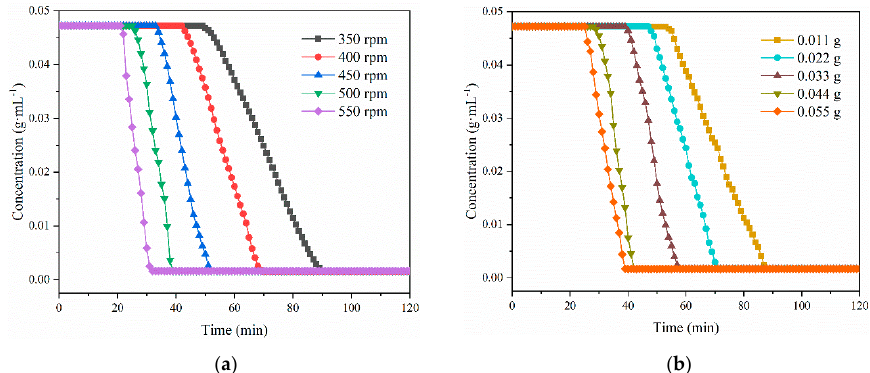
Figure 16. The concentration variation of sacubitril during the co-crystallization of LCZ696 by ( a ) different stirrer speed and ( b ) different quality of crystal seeds, respectively.